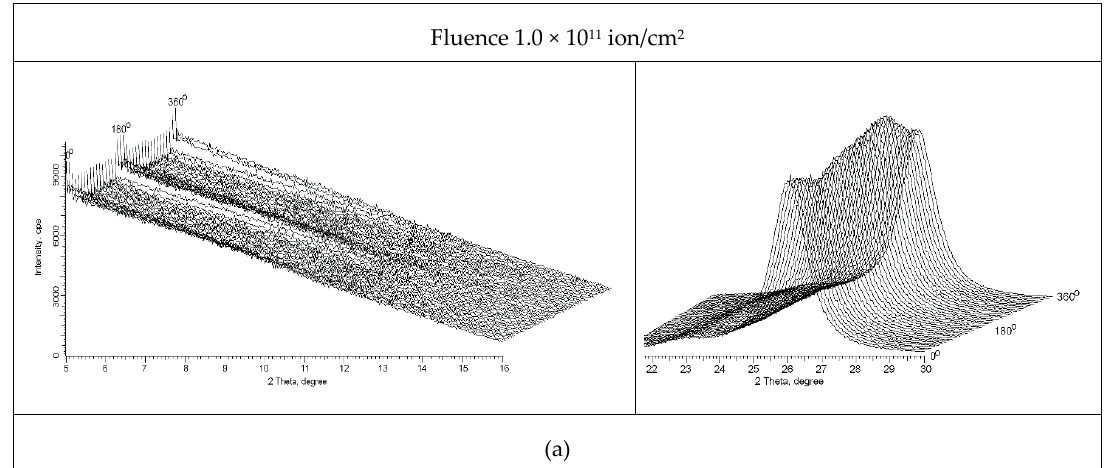
Figure 4. X-ray diffraction patterns of test samples polymer films: ( a ) irradiated Kr 13+ ions; ( b ) Figure 4. X-ray di ff raction patterns of test samples polymer films: ( a ) irradiated Kr 13 + ions; ( b ) irradiated irradiated Kr 14+ ions; ( c ) irradiated Kr 15+ ions. Kr 14 + ions; ( c ) irradiated Kr 15 + ions.